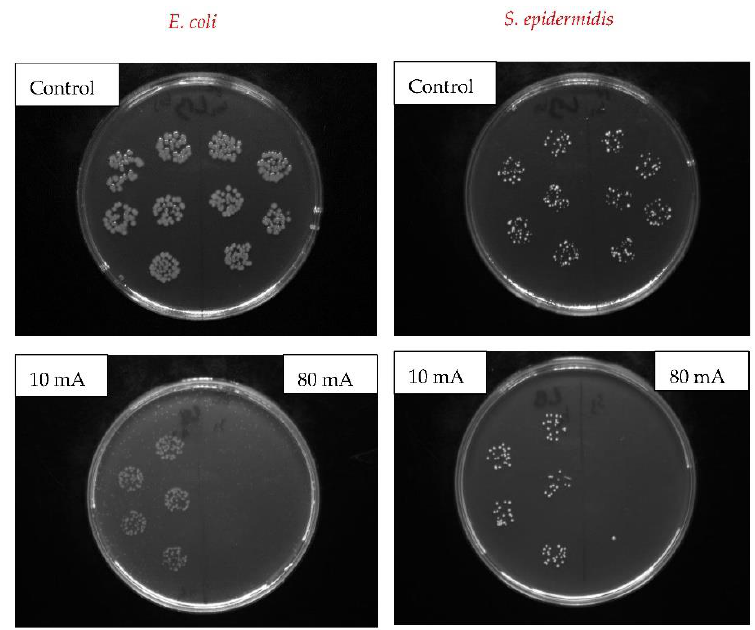
Figure 10. Images of Petri dishes with grown colony-forming units of E. coli and S. epidermidis on control samples in comparison to samples sputtered with Ag for 400 s at 10 and 80 mA current.